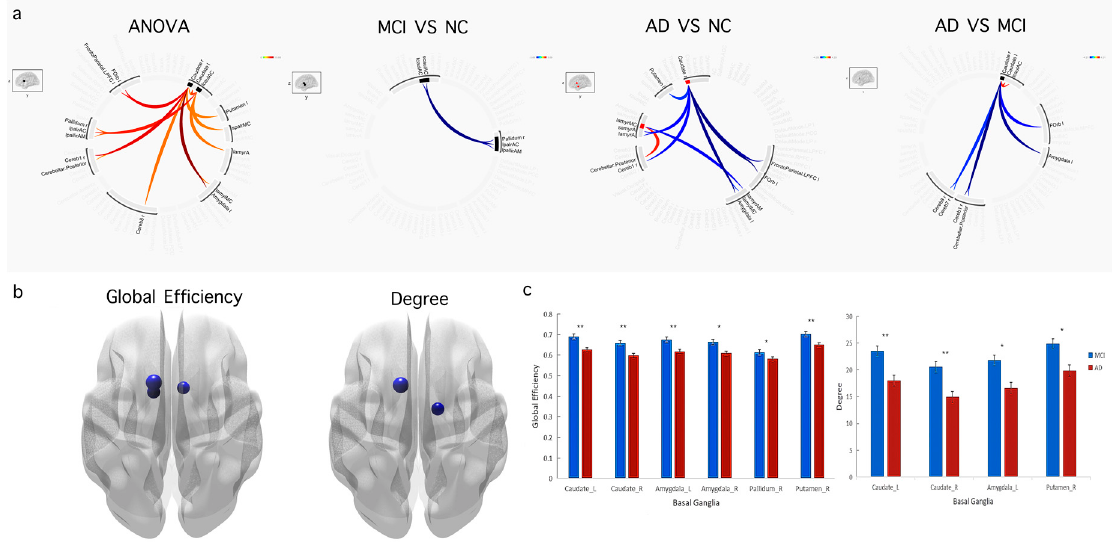
Figure 3. ( a ) Functional connectivity with significant differences (voxel-level p < 0.01, cluster-level p < 0.05, FDR-corrected) among the AD, MCI, and NC groups. ( b ) Graph theory analyses with significant differences ( p < 0.01, no correction) among patients with AD and those with MCI. ( c ) Differences in graph theory indices of the basal ganglia between the patients with AD and those with MCI. (**—represents significant differences ( p < 0.01); *—represents slight differences ( p <